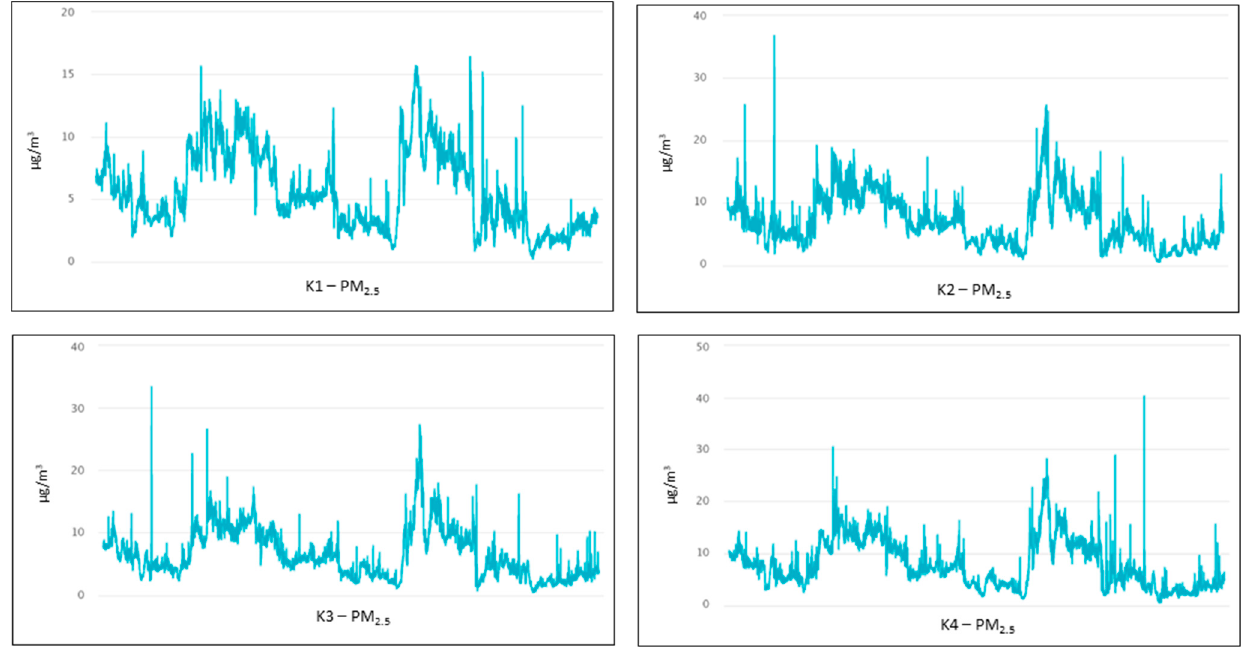
Figure 3. PM 2.5 mass concentration in μ m/m 3 as (10 min) time series for each of 4 measurement locations K1, K2, K3, and K4 for the measuring period from 20 August to 15 September 2022.